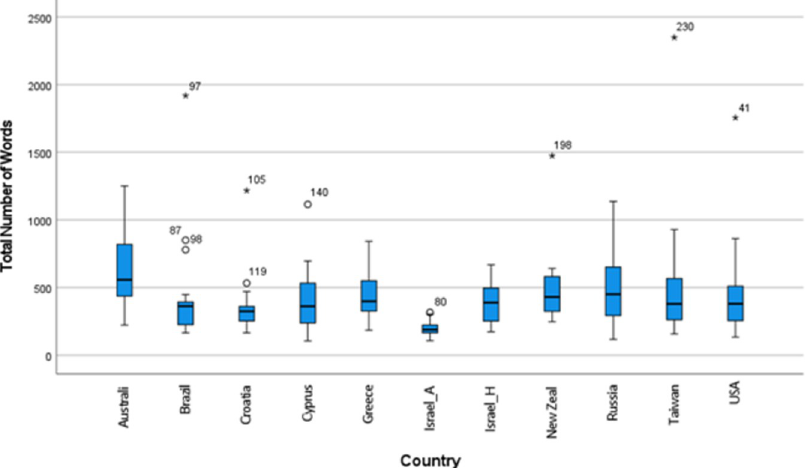
Fig 2. Total number of words by country. Indicates an outlier (more than 1 standard deviation [SD] from the mean; � outlier > 2 SD from the mean; numbers refer to case numbers in SPSS.